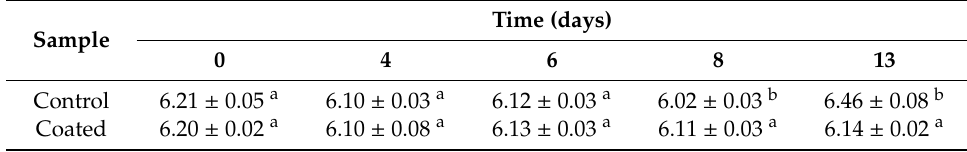
Table 2. PH of coated salmon fillets and the untreated control, stored at 2.0 ± 0.5 ◦ C ( n =